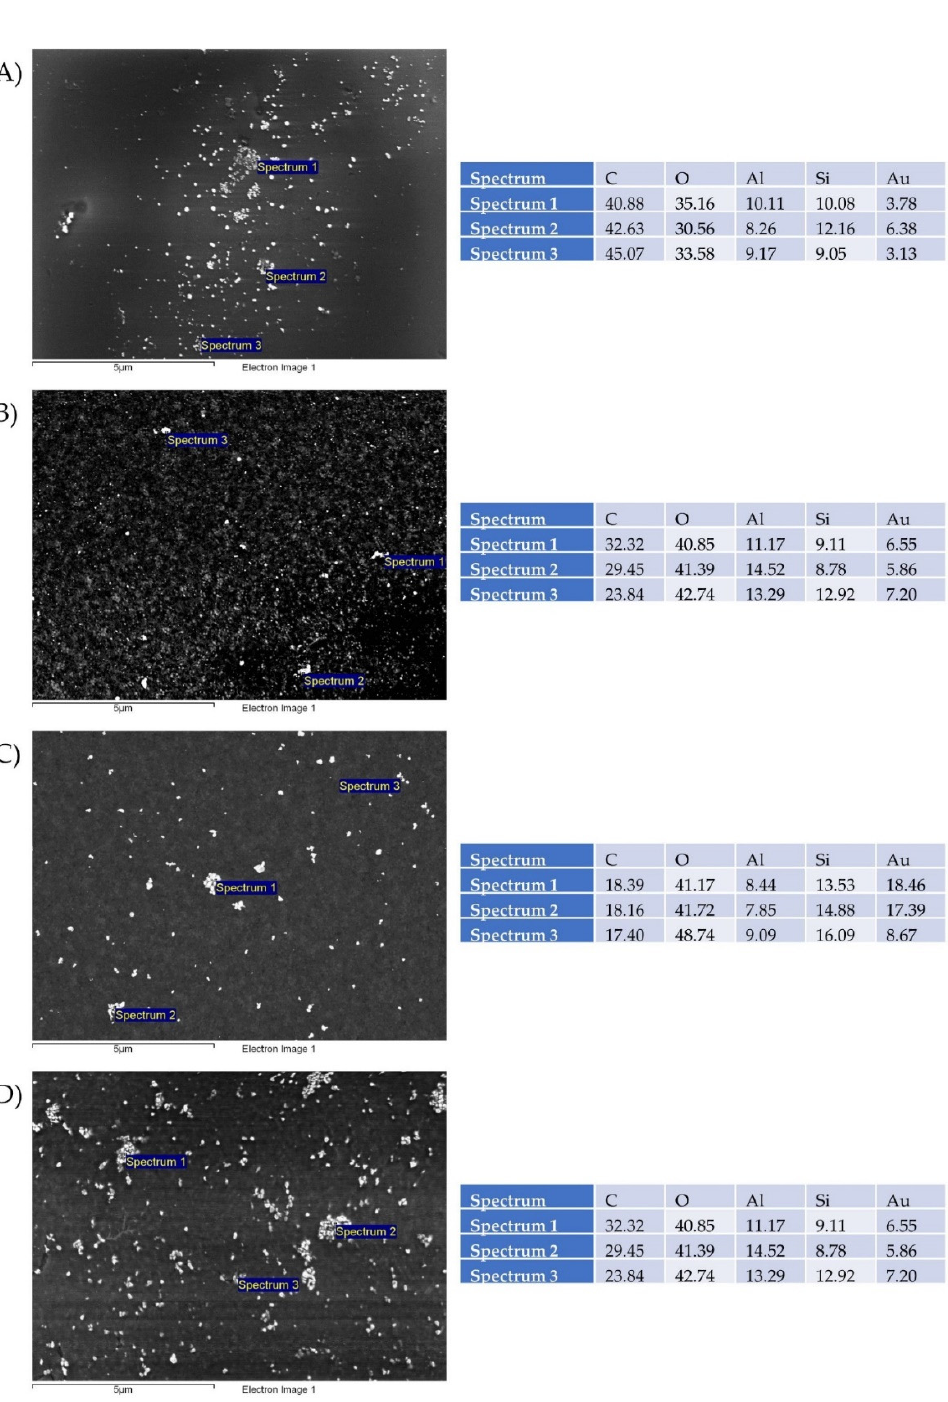
Figure 9. SEM/EDS studies of printed patterns on photo paper with precursor concentrations of: A ) AuCl 1 g/L, B ) AuCl 0.5 g/L, C ) AuAc 0.5 g/L, and D ) AuAc 1 g/L. The values are presented